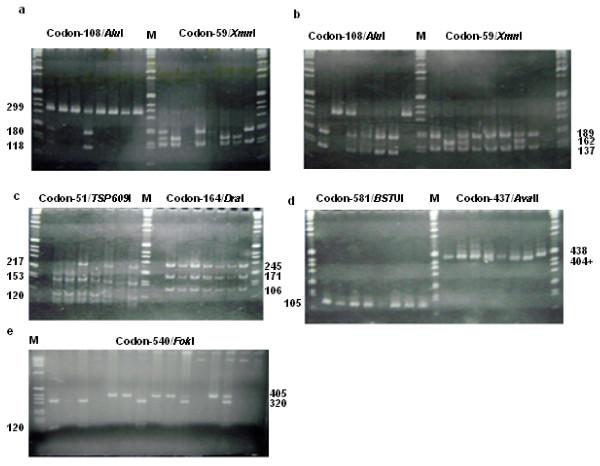
Polyacrylamide gels of the restriction digest of the PCR products ((a)AluI and xmnI; (b) AluI and xmnI; (c)TSP609I and DraI; (d) BSTUI and AvaII; (e) FokI) of the tests for the polymorphisms of the dhfr and dhps genes. Fragment sizes are in bp.